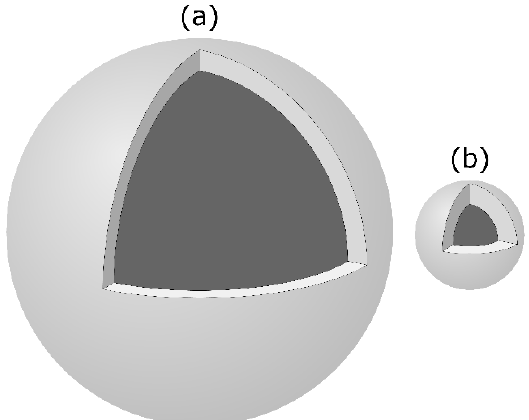
Figure 9. Comparison of the relative size and substructure of the nanocluster complexes formed by OPN 1–149 ( a ) and β -casein 1–25 ( b ). The illustration shows the core-shell substructure by removing a one eighth segment of the shell. Z-average core radii are 12.5 and 2.4 nm and shell thicknesses 1.5 and 1.6 nm for the OPN 1–149 and β -casein 1–25 complexes, respectively [24,111].